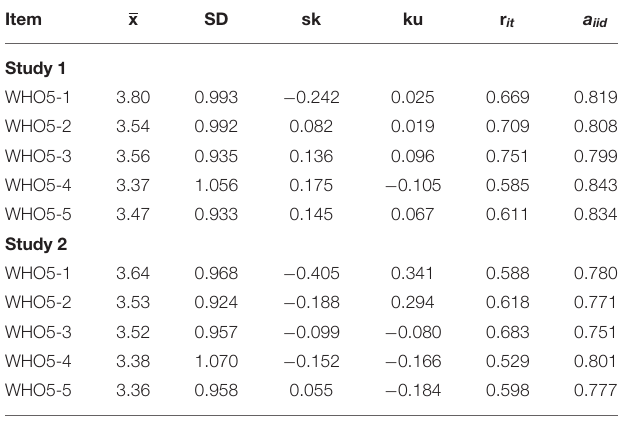
TABLE 1 | Descriptive statistics for the WHO-5 items in Study 1 and Study 2.